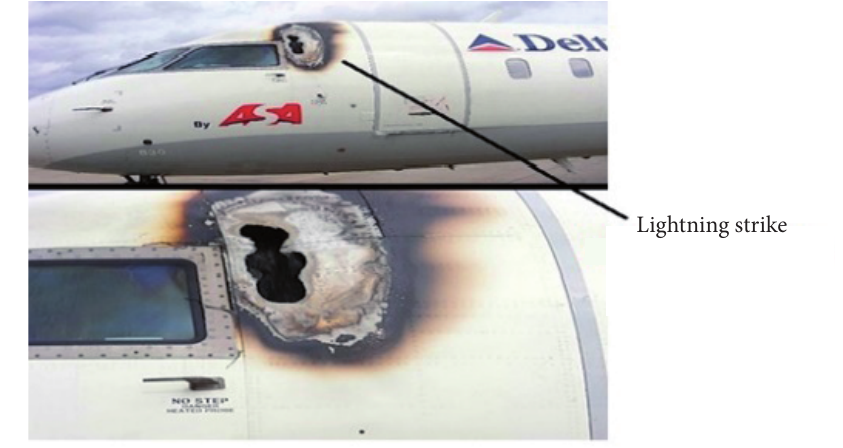
Figure 7. Lightning strike effects (Goraj 2004).